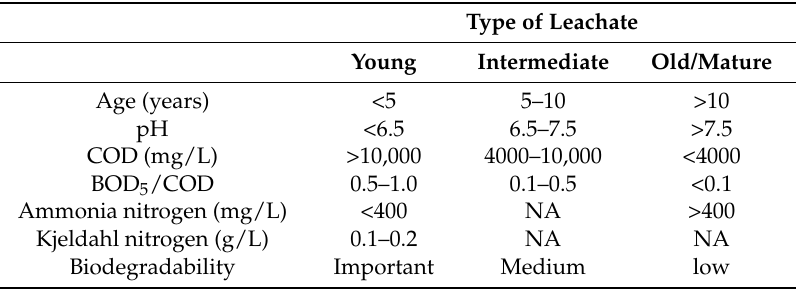
Table 1. Characteristics of leachate depending on its age